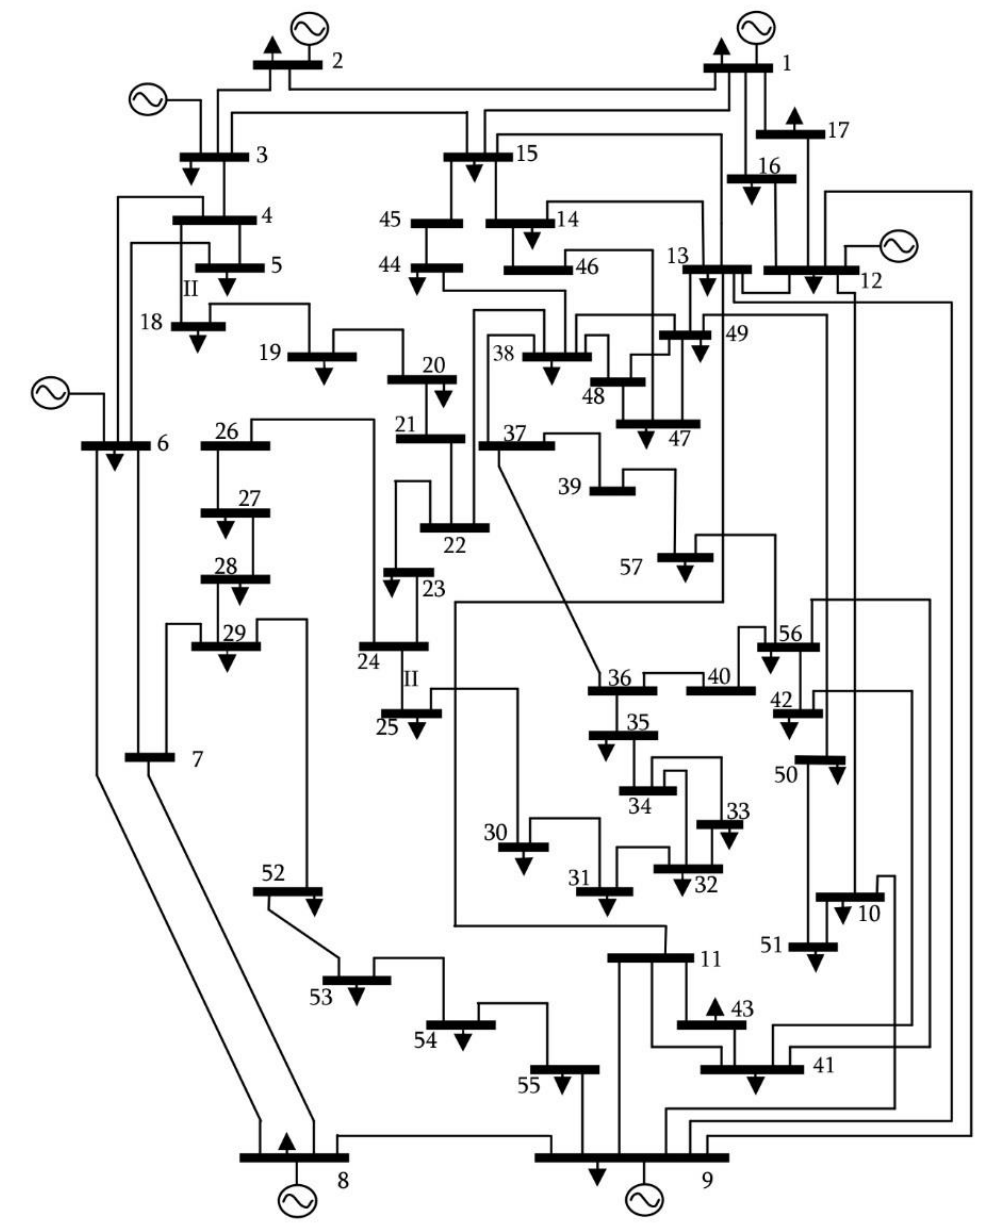
Figure A2. Single-line diagram of the IEEE 57-bus test system. Appendix C Data for Test System 3 (IEEE 118-bus Test Table A6. System data of units with single-fuel coefficients considering valve-point effect and emission coefficients.